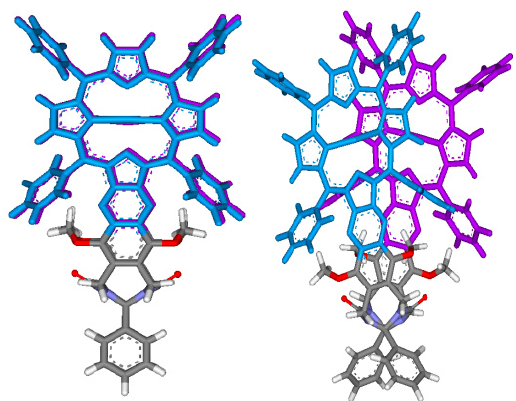
Figure 4. Effect of glycoluril spacer twisting in tweezer 3 , monitored via the Ph-C-C-Ph dihedral angle (viewed along the Ph-C-C-Ph bond, cf. Figure 3). Left : dihedral angle = 0°, right : dihedral angle = 30°.